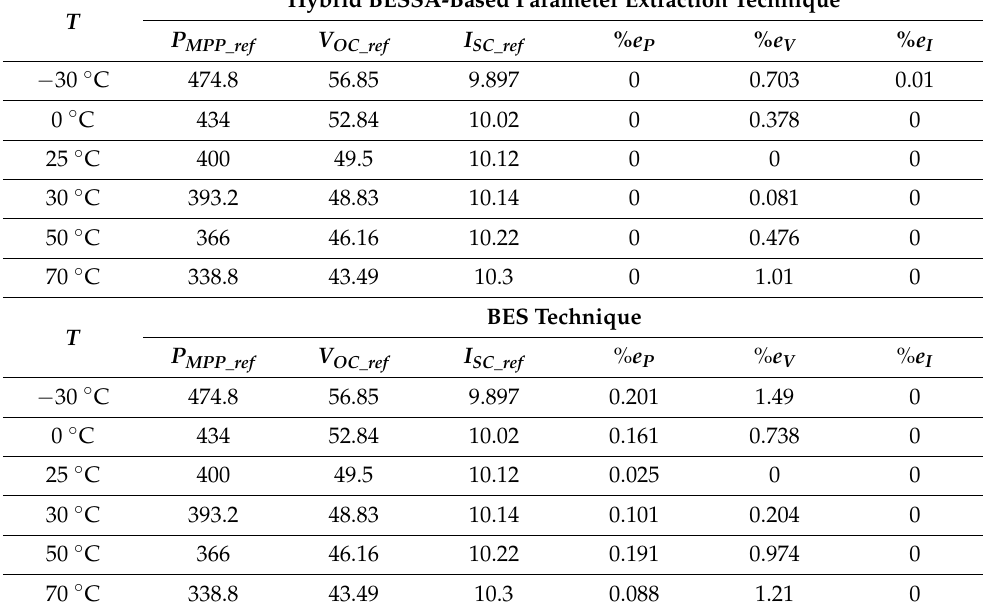
Table 9. Reference values and percentage error obtained for Module AS-M3607-S with G fixed at 1000 W/m 2 and T varying from − 30 ◦ C to 70 ◦